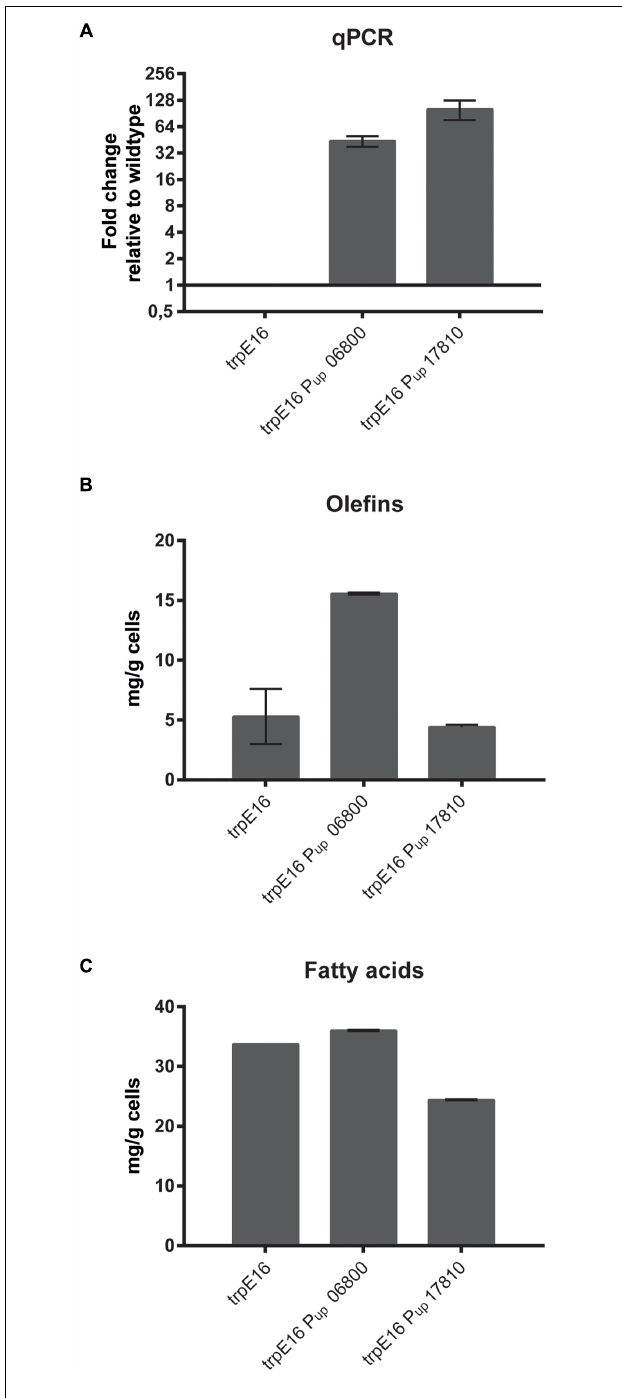
FIGURE 1 | Promoter-up exchange mutants of M. luteus BCKD complex gene cluster candidates. Gene expression analysis by qPCR (A) , cellular olefin amounts (B) and cellular fatty acid amounts in minimal medium (C) after replacement of the native promoters with stronger promoters (see text) relative to the parental strain. The qPCR data is obtained from three technical measurements of two biological samples. In the case of the qPCR data a log 2 -scale was employed on the y -axis. The olefin and fatty acid concentrations were determined from two biological replicates. Error bars represent standard